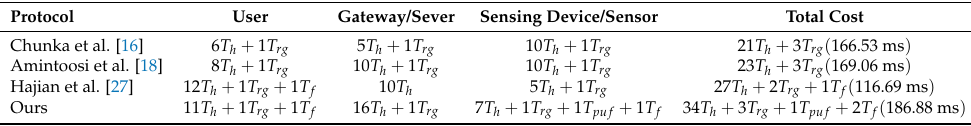
Table 4. Computation cost of login and authentication phase.